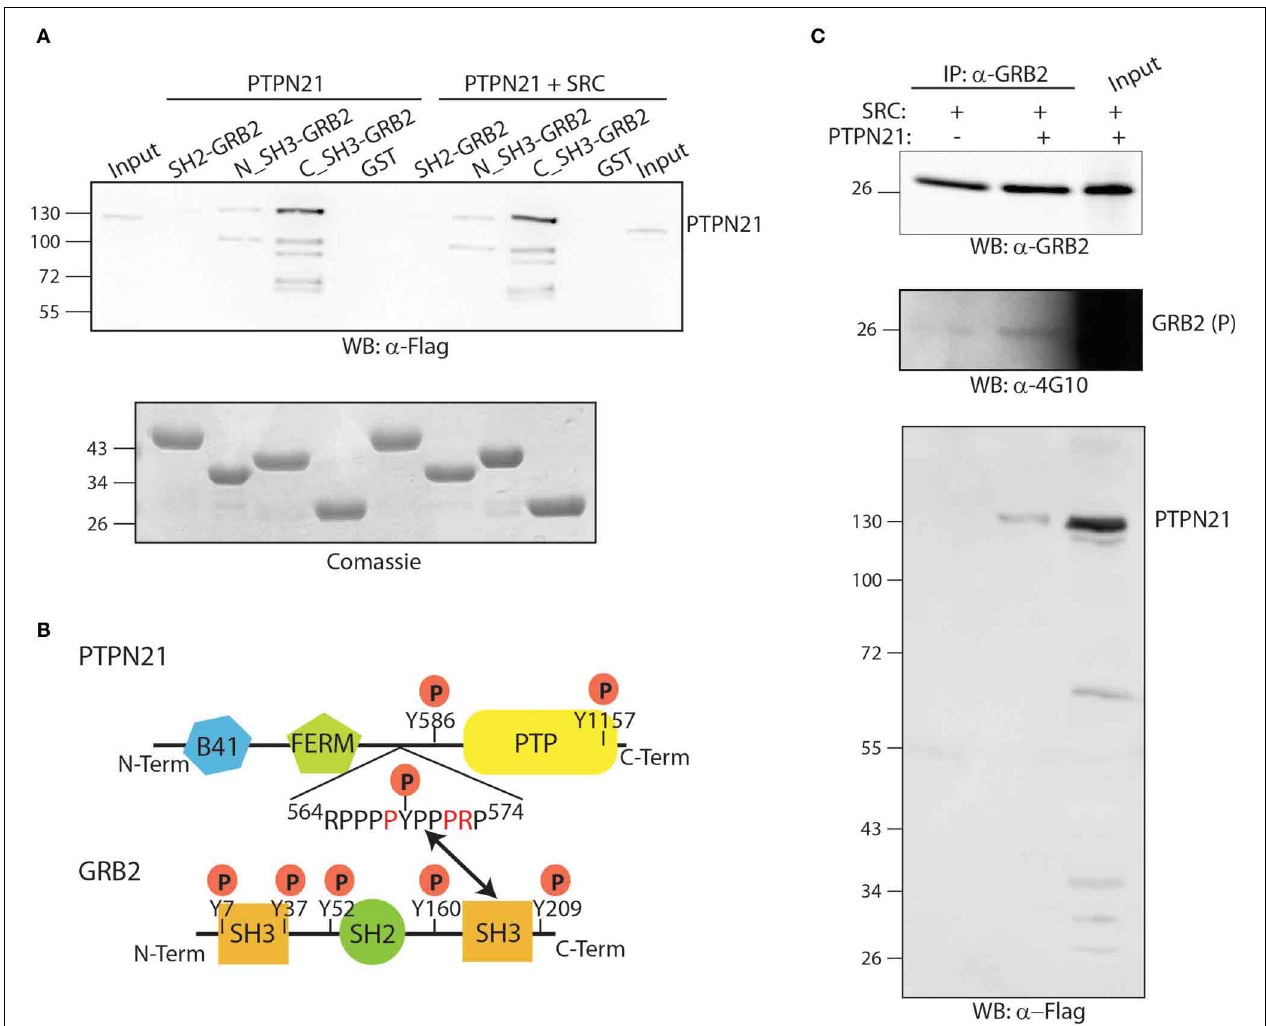
FIGURE 5 | The PTPN21 phosphatase physically associates with the C-terminal SH3 domain of GRB2. (A) GST fusion proteins of the N-terminal, C-terminal SH3 domain as well as the SH2 domain of GRB2 were incubated with a protein extract of HeLa cells transiently transfected with Flag-PTPN21 in presence or in absence of constitutively activated Y527F SRC kinase. Affinity-purified SH2 and SH3 domains ligands were separated by SDS-PAGE and transferred onto cellulose membranes. The blots were probed with anti-Flag (WB: α -4G10) and anti-phosphotyrosine (WB: α -4G10) antibodies. The cell lysate (input) and the sample affinity-purified with the GST protein